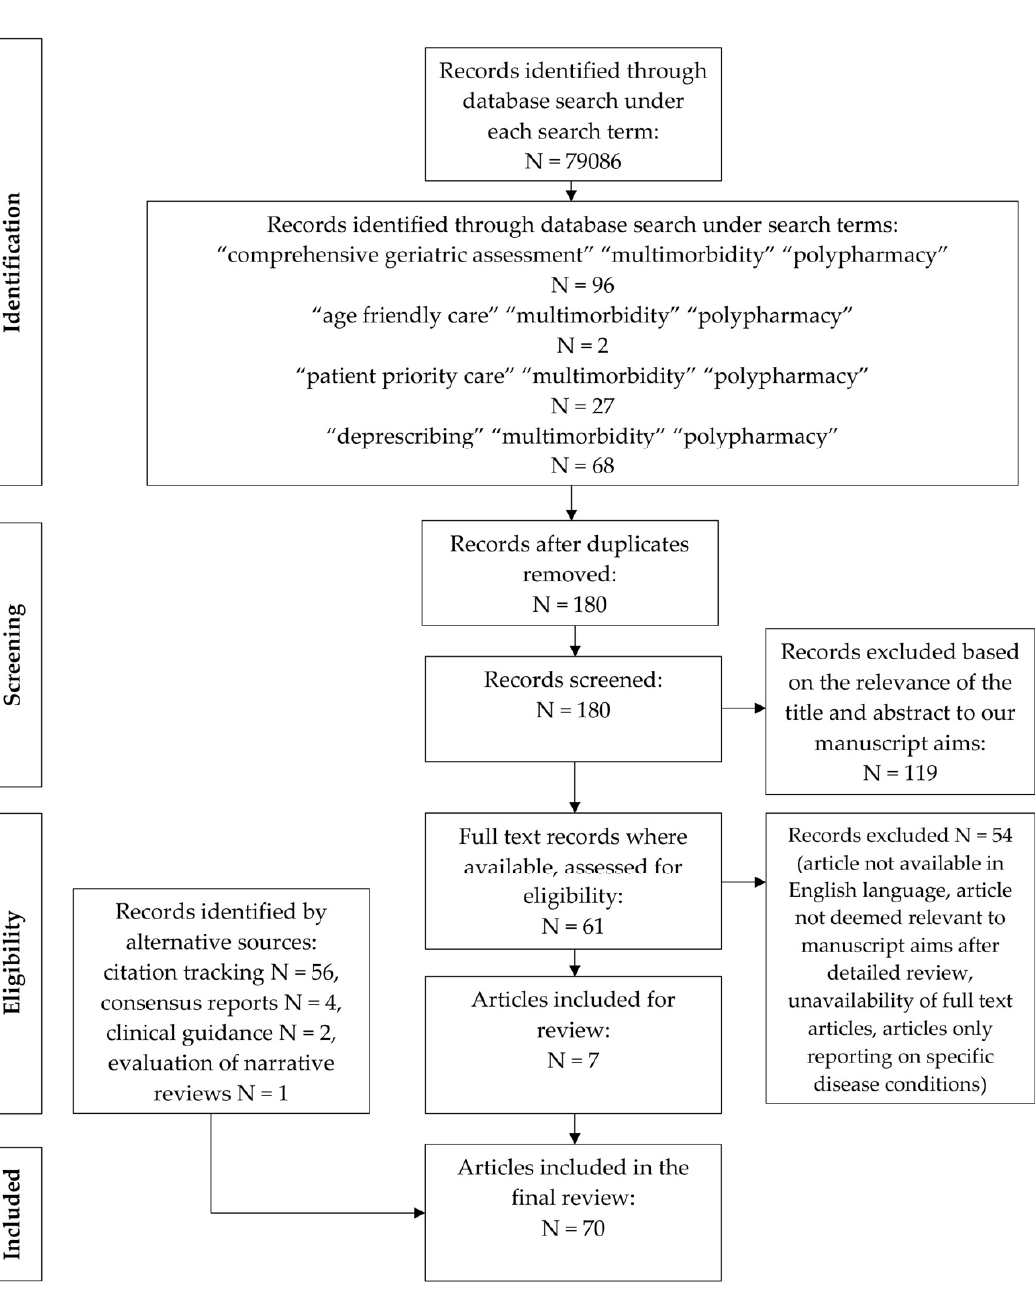
Figure A1. Flow chart for article Figure A1 Flow chart for article selection.